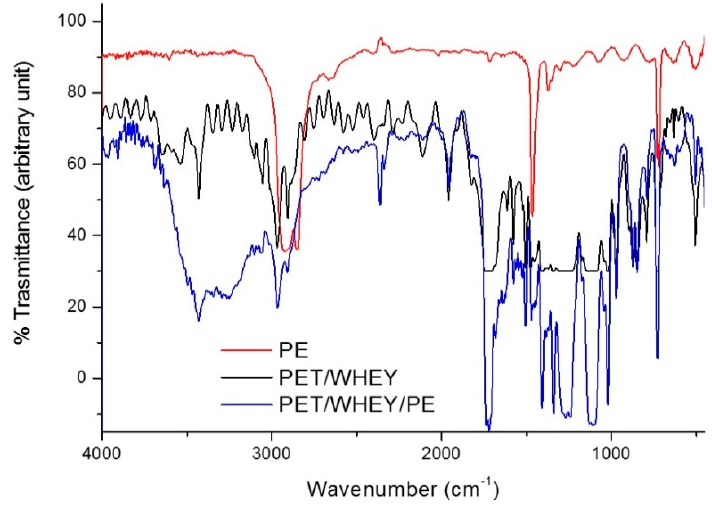
Figure 5. FT-IR spectra of multi-layer samples PE, PET/Whey, and PET/Whey/PE.